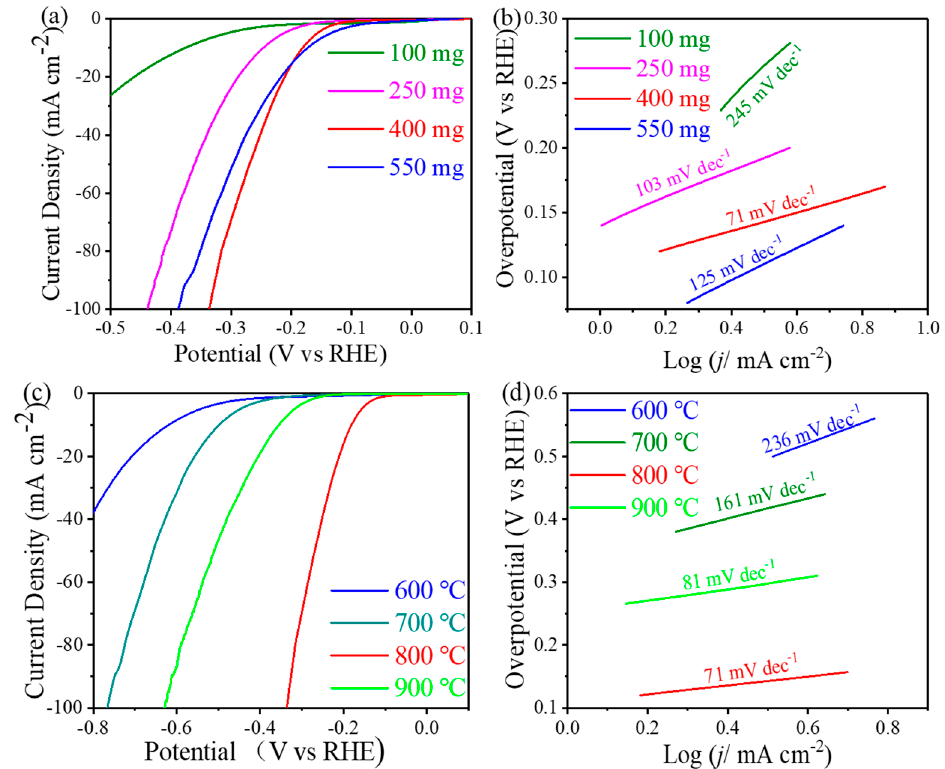
Figure 3. ( a ) Polarization curves of MoP/NPC-100 mg, 250 mg, 400 mg, 550 mg (dosage of ammonium molybdate) in 0.5 M H 2 SO 4 ; ( b ) Tafel plots of MoP/NPC-100 mg, 250 mg, 400 mg, 550 mg in 0.5 M H 2 SO 4 ; ( c ) polarization curves of MoP/NPC-600 °C, 700 °C, 800 °C, 900 °C in 0.5 M H 2 SO 4 ; ( d ) Tafel 0.5 M H 2 SO 4 ; ( c ) polarization curves of MoP/NPC-600 ◦ C, 700 ◦ C, 800 ◦ C, 900 ◦ C in 0.5 M H 2 SO 4